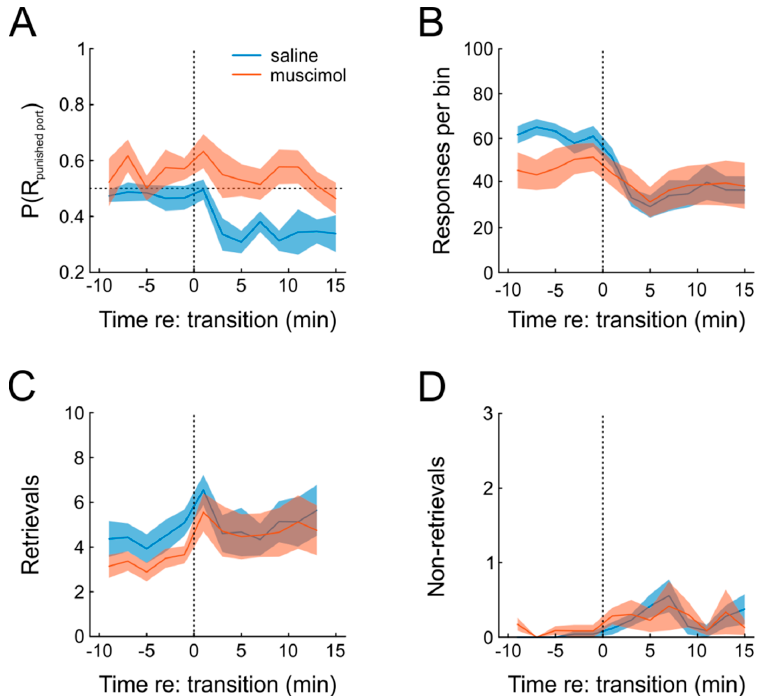
Figure 5. Adaptation to punishment and involvement of mPFC. ( A ) Mean P(R L ) in consecutive, non-overlapping 2-min bins across animals after saline (blue) or muscimol (red) infusion. P(R L ) was rectified, such that values <0.5 signify a preference for the unpunished response port. Under saline, the animals exhibited a clear preference for the non-punished option. Vertical dotted line highlights the time of punishment introduction. ( B ) As in (A), but showing operant responses. ( C ) As in ( A ), but showing the number of rewards retrieved per time bin. ( D ) As in ( A ), but showing the number of non-retrieved rewards in all panels. Shading represents